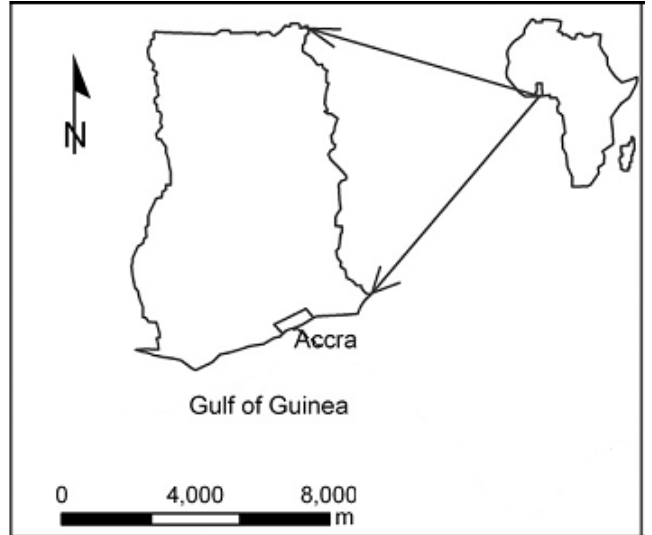
Figure 1. The location of Accra in Ghana (source: